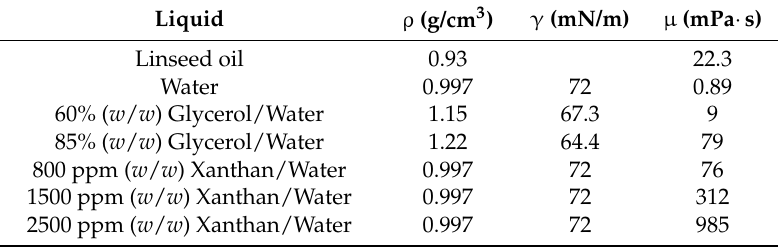
Table 1. Main physical properties of the liquids used in this study: density ρ , surface tension γ , dynamic viscosity µ (for xanthan solutions, the viscosity data correspond to a shear rate of 1 s ´ 1 ). All data refer to a temperature of 25 ˝